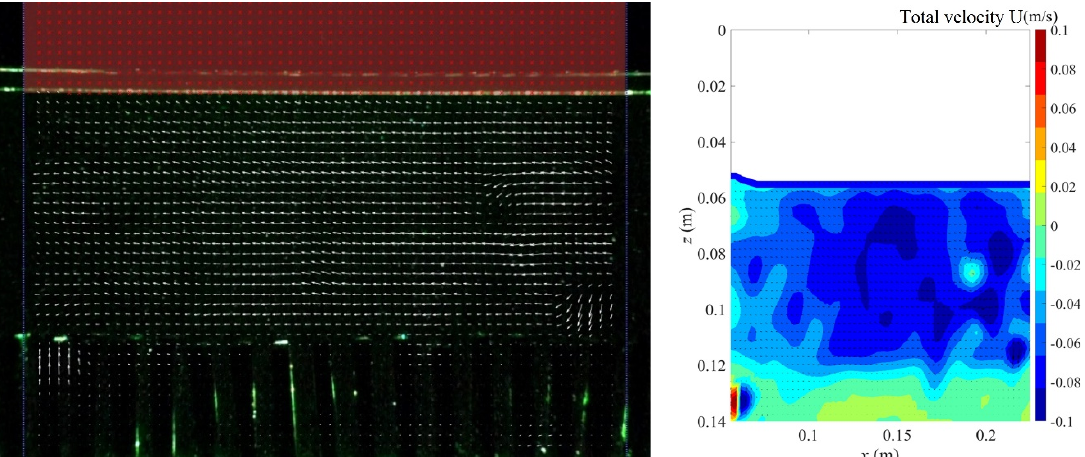
Figure 17. Velocity field and distribution of a long-period wave trough ( T = 2.0 s) passing through vegetation structures ( ϕ = 0.5 cm and d = 5 cm).